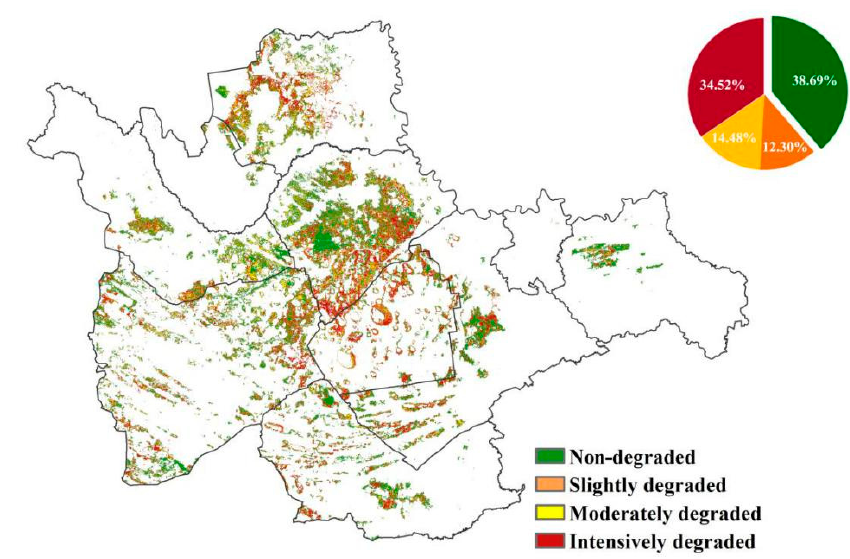
Figure 8. Spatial distribution of different grassland degradation degrees over West Jilin in 2017.